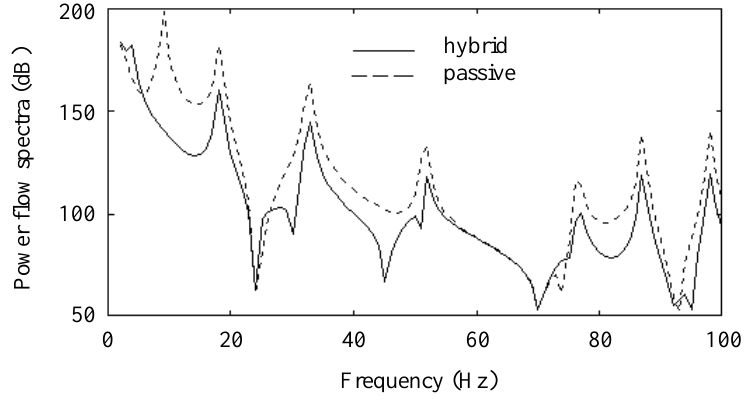
Fig. 8. Hybrid control ( K c = 5 ) effect compared to a passive one ( K c = 0 ).